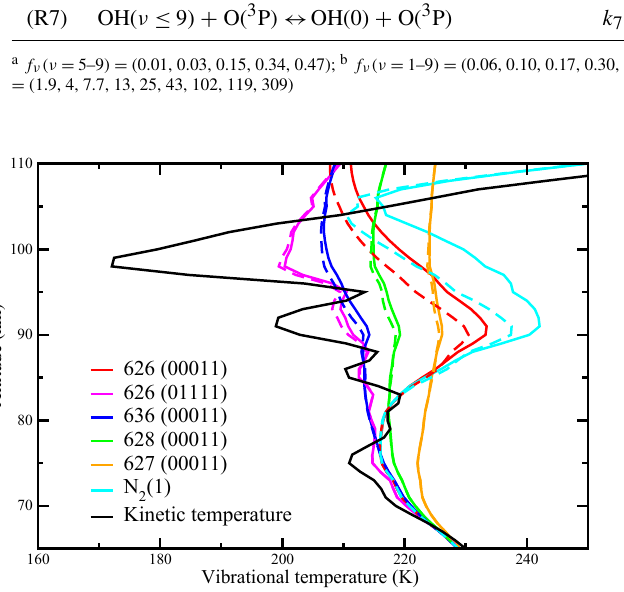
Figure 1. Nighttime vibrational temperatures of CO 2 (00011) of four CO 2 isotopes, CO 2 (01111) of main CO 2 isotope, and of N 2 (1) for SABER scan 22, orbit 01264, 77 ◦ N, 3 March 2002. Solid lines: [(OH-N2 1Q) & (OH-O2 MQ) & Reactions (R4), (R5)]; dashed lines: [(OH-N2 3Q) & (OH-O2 1Q) & Reaction (R7)]; see Sect. 2.3 for a description of calculation